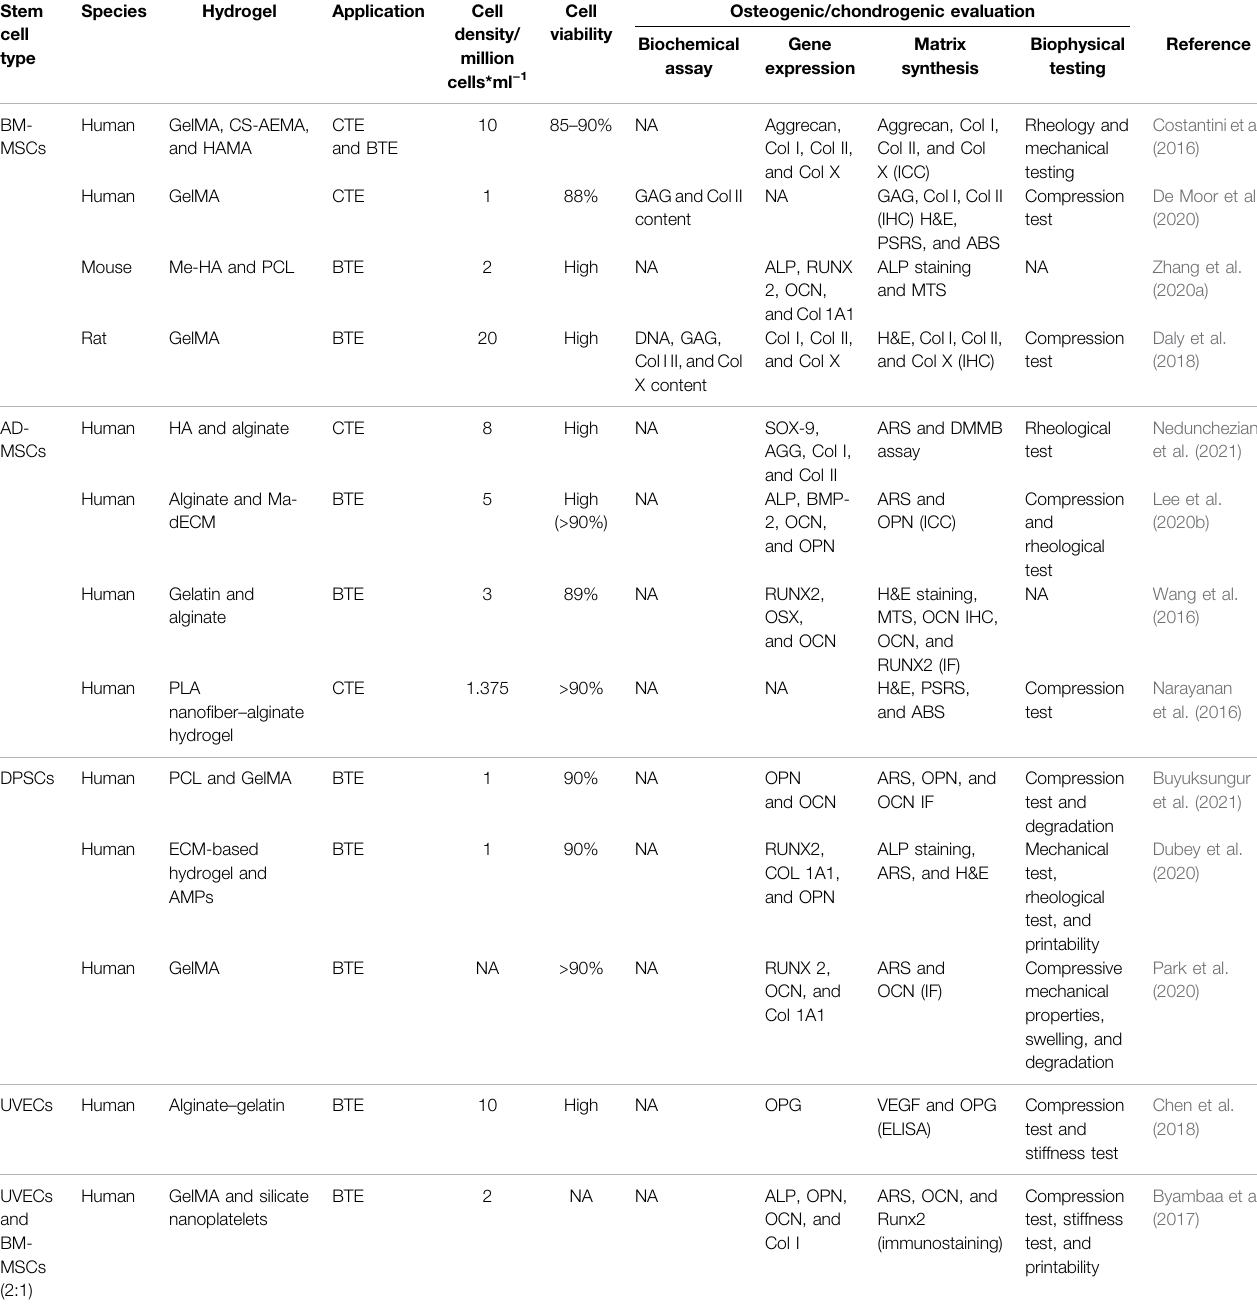
TABLE 3 | Stem cell-laden in the hydrogel and the biochemical